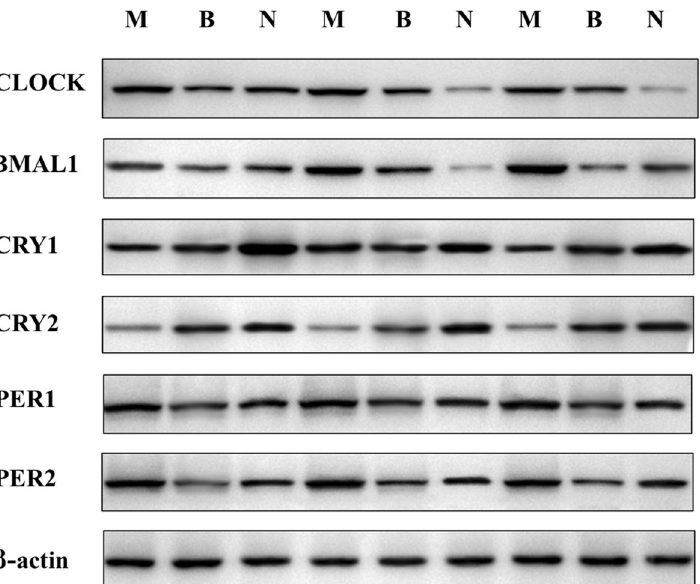
Figure 4. The density of each band was measured by densitometry, and β-actin was used as an internal control. M malignant nodule group; B benign nodule group; N adjacent normal group. Full-length blots/gels were presented in Supplementary